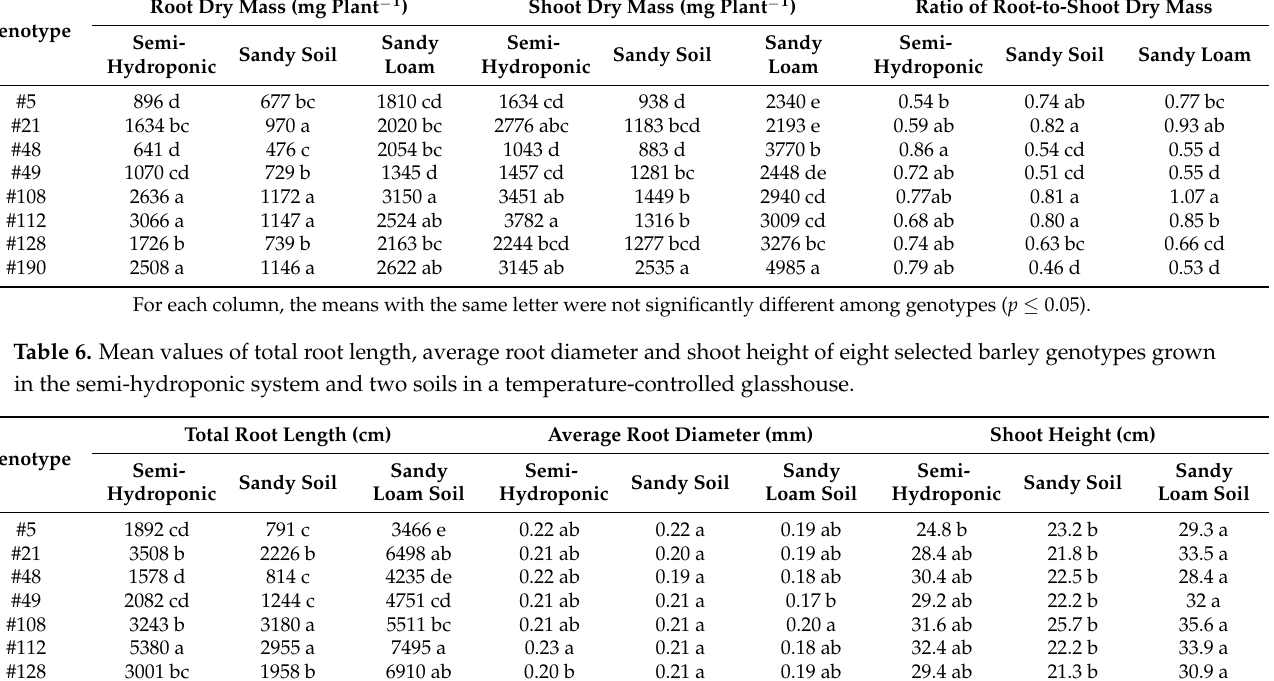
Table 5. Mean values of root dry mass, shoot dry mass and ratio of root-to-shoot dry mass of eight selected barley genotypes grown in the semi-hydroponic system and two soils in a temperature-controlled glasshouse. Genotype